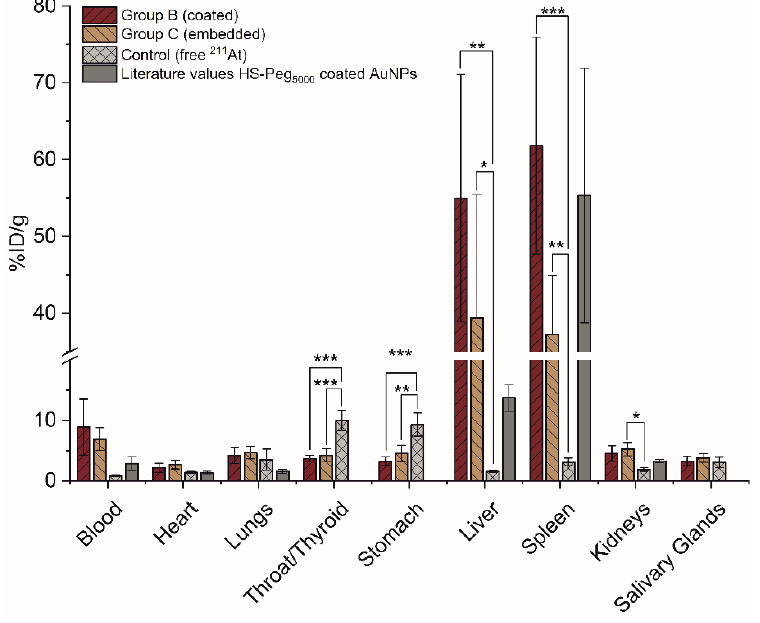
Figure 5. Ex vivo biodistribution analysis at 21 h post-injection of 211 At-AuNPs as Groups B and C (n = 5) and free 211 At (n = 3), administered to healthy Balb/c mice. In the figure, literature values of the biodistribution of AuNPs with a similar size (73 ± 6 nm) and the same coating materials (HS-PEG 5000 ) were included [23]. The data were analyzed by a one-way ANOVA followed by a Tukey’s multiple comparison test with the following significance thresholds (*) p > 0.3, (**) p > 0.15, (***) p < 0.025.